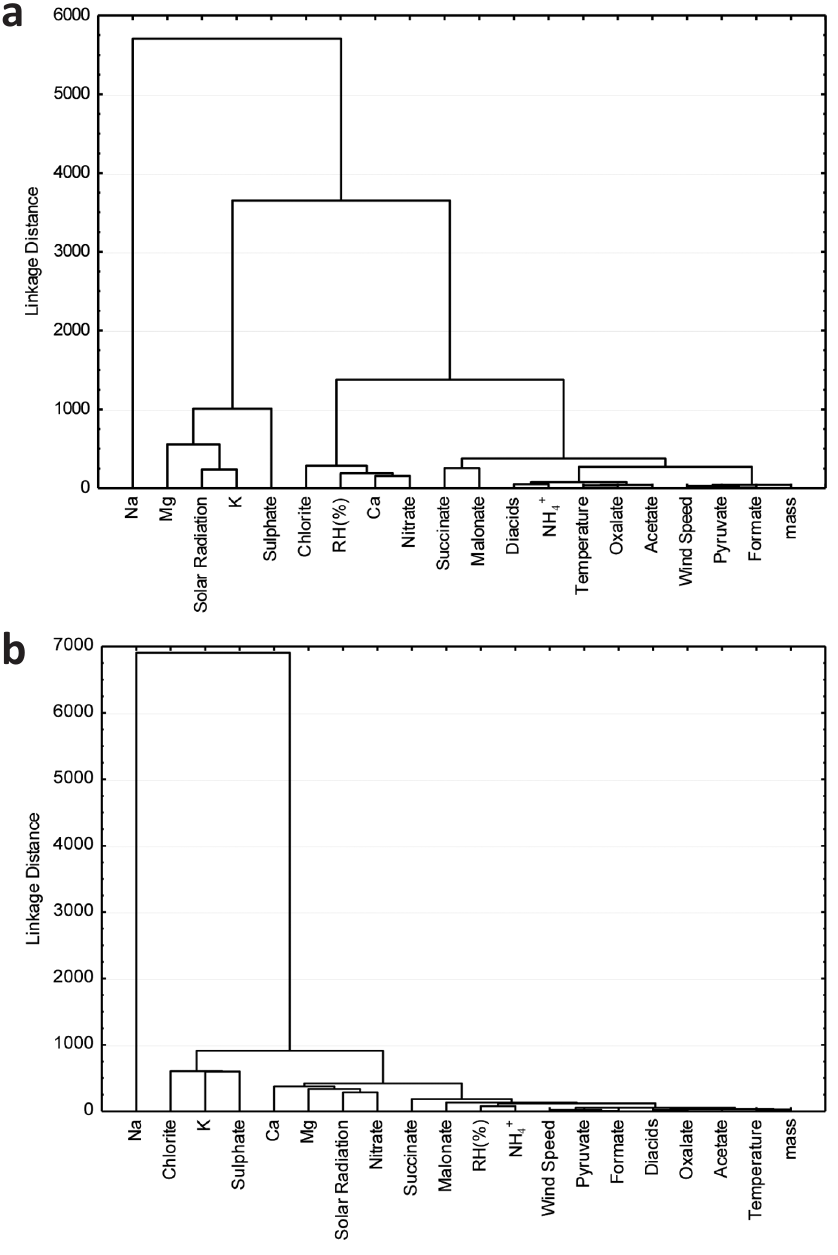
Fig. 6 - Cluster analysis at 95 % confidence level for (a) PM2.5 and (b) PM10, from